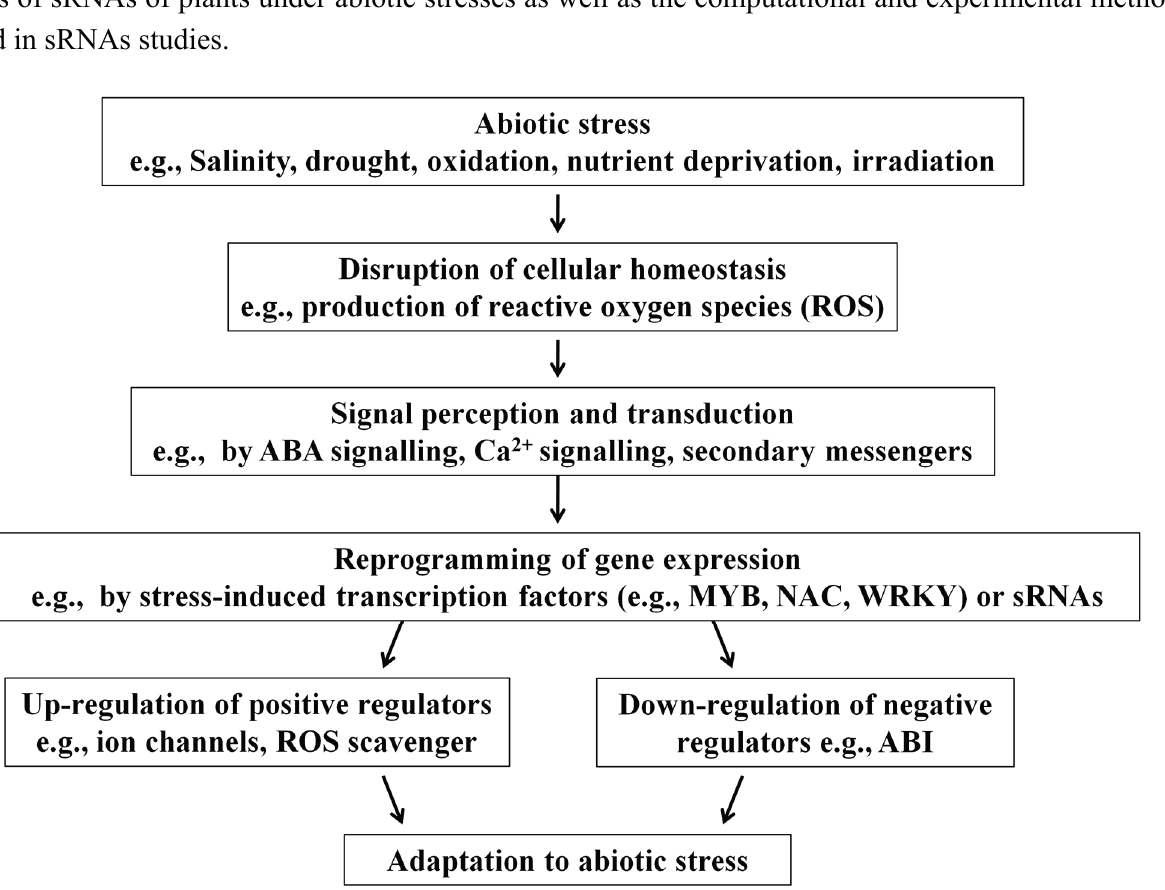
Figure 1. A simplified representation to illustrate the central role of gene expression reprogramming in triggering the adaption to abiotic stresses. Upon abiotic stresses, cellular homeostasis is disrupted. The signal is sensed and transduced by signaling molecules. This brings forth the reprogramming of gene expression which involves transcriptional factors and sRNAs, resulting in the up-regulation of positive regulators and down-regulation of negative